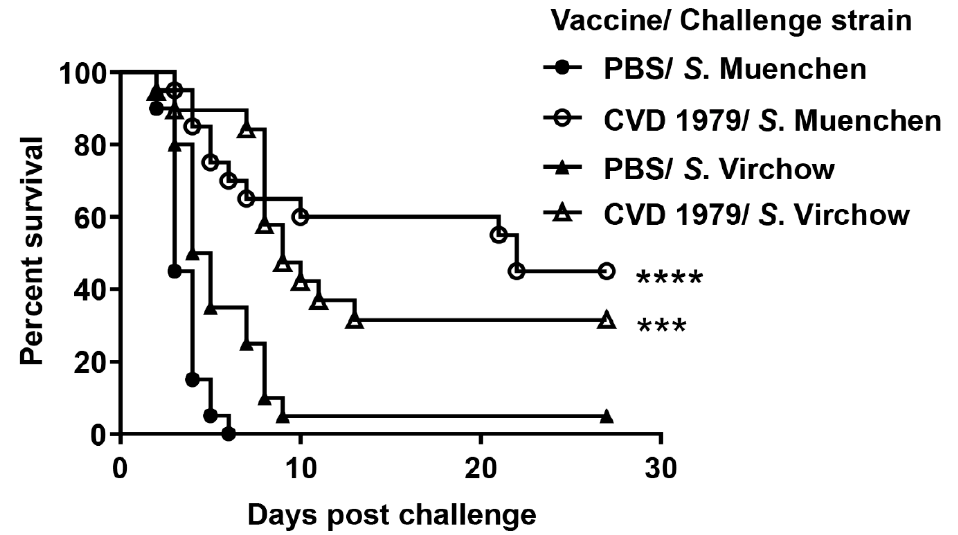
Figure 2. Survival of mice after lethal challenge with S . Muenchen (O:8 [C 2 –C 3 ]) and S . Virchow (O:6,7 [C 1 ]). Mice immunized with PBS or CVD 1979, three weeks apart and subsequently challenged intraperitoneally with an LD 100 of S . Muenchen ATCC 8344 and S . Virchow Q23. Statistically significant differences in survival curves between the vaccinated and control mice for each challenge strain were determined by log rank test. *** p < 0.001; **** p < 0.0001.